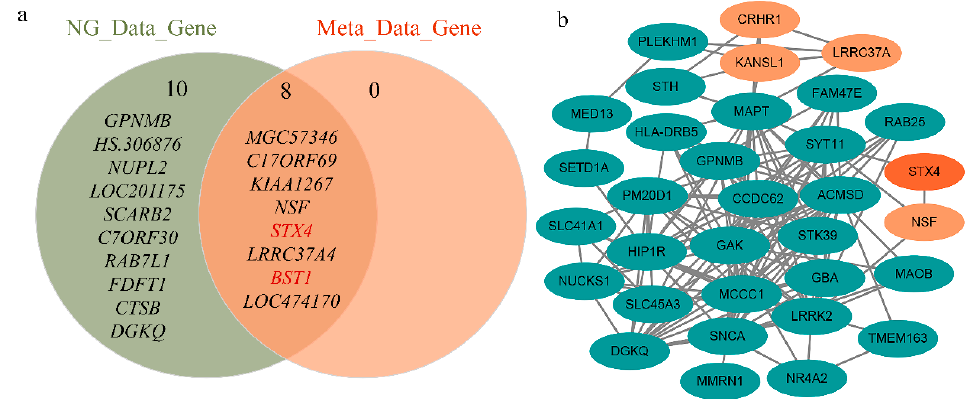
Figure 4. Independent dataset validation of six identified risk genes. ( a ) Significant genetic intersection of independent GWAS data and meta-analysis GWAS data tested. The most significant genes of the latest GWAS data and the significant genes after SMR and HEIDI include STX4 and BST1 , respectively. ( b ) Protein–protein interaction network of significant genes in the PD-Gene identified by SMR and HEIDI. STX4 interacts with known PD risk genes.